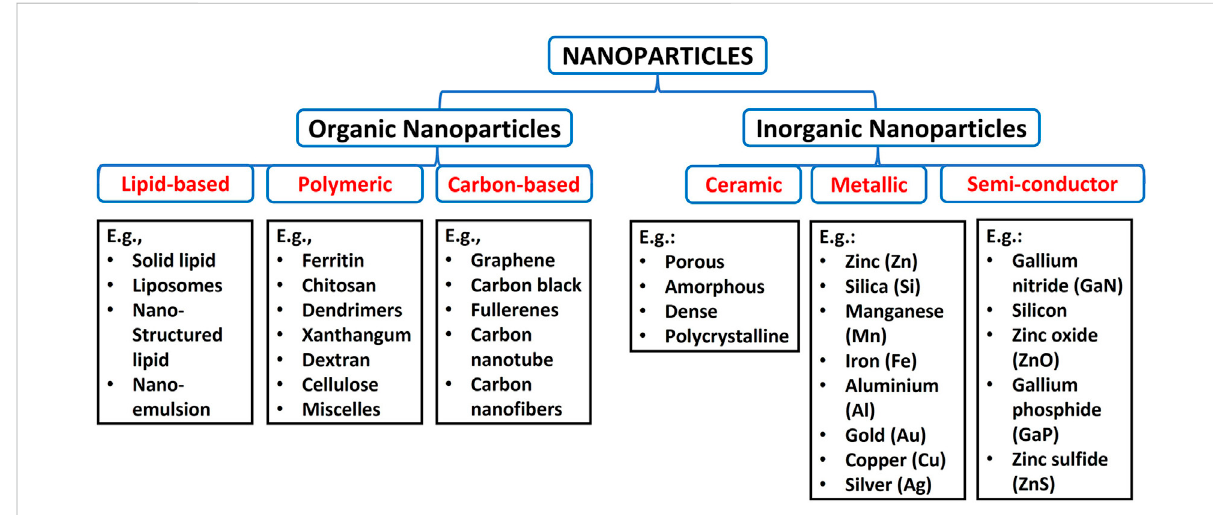
FIGURE 1 Types of nanoparticles, subdivisions, and examples of each